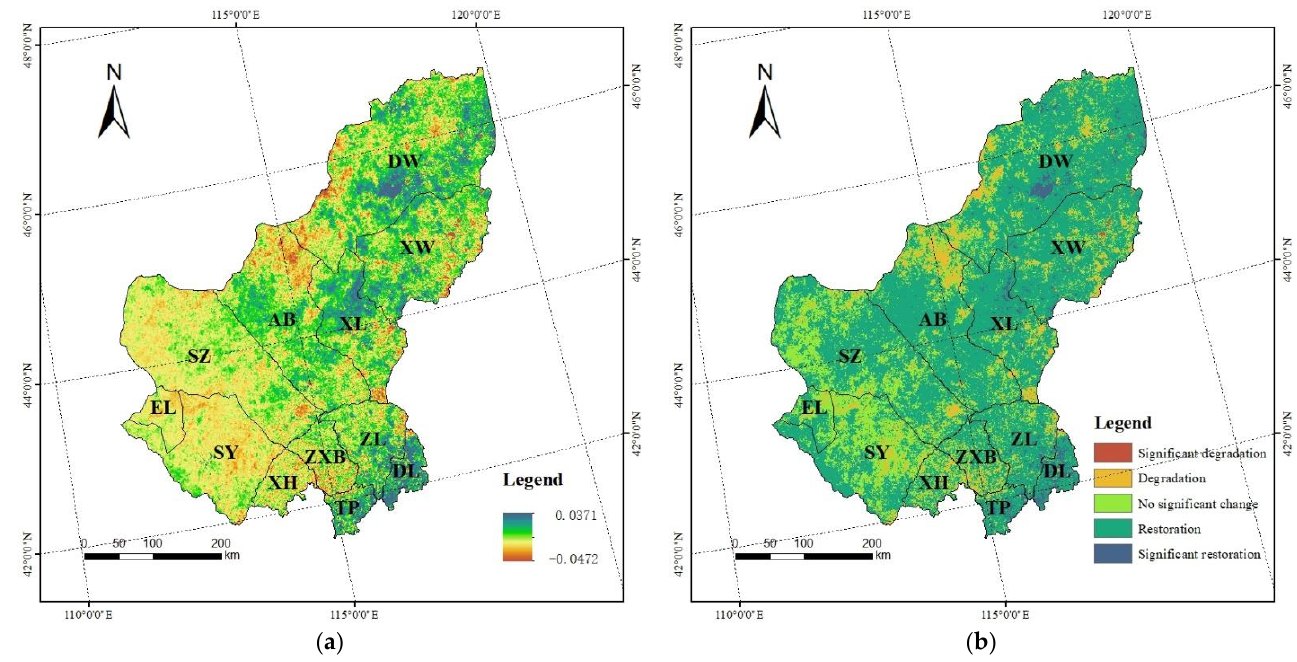
Figure 5. Spatial variation trends of NDVI in 2000 – 2019: ( a ) spatial distribution of NDVI variation trends; ( b ) reclassification results of spatial variation trends. Table 3. Percentage of grassland variation trends in different zones. Significant Degradation